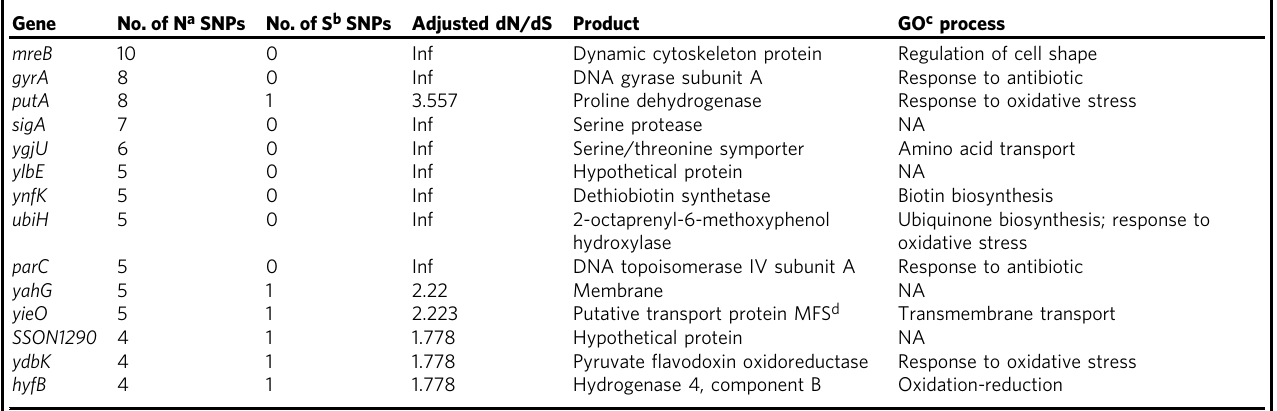
Table 2 Genes predicted to be under selection in the CenAsiaIII Shigella sonnei population